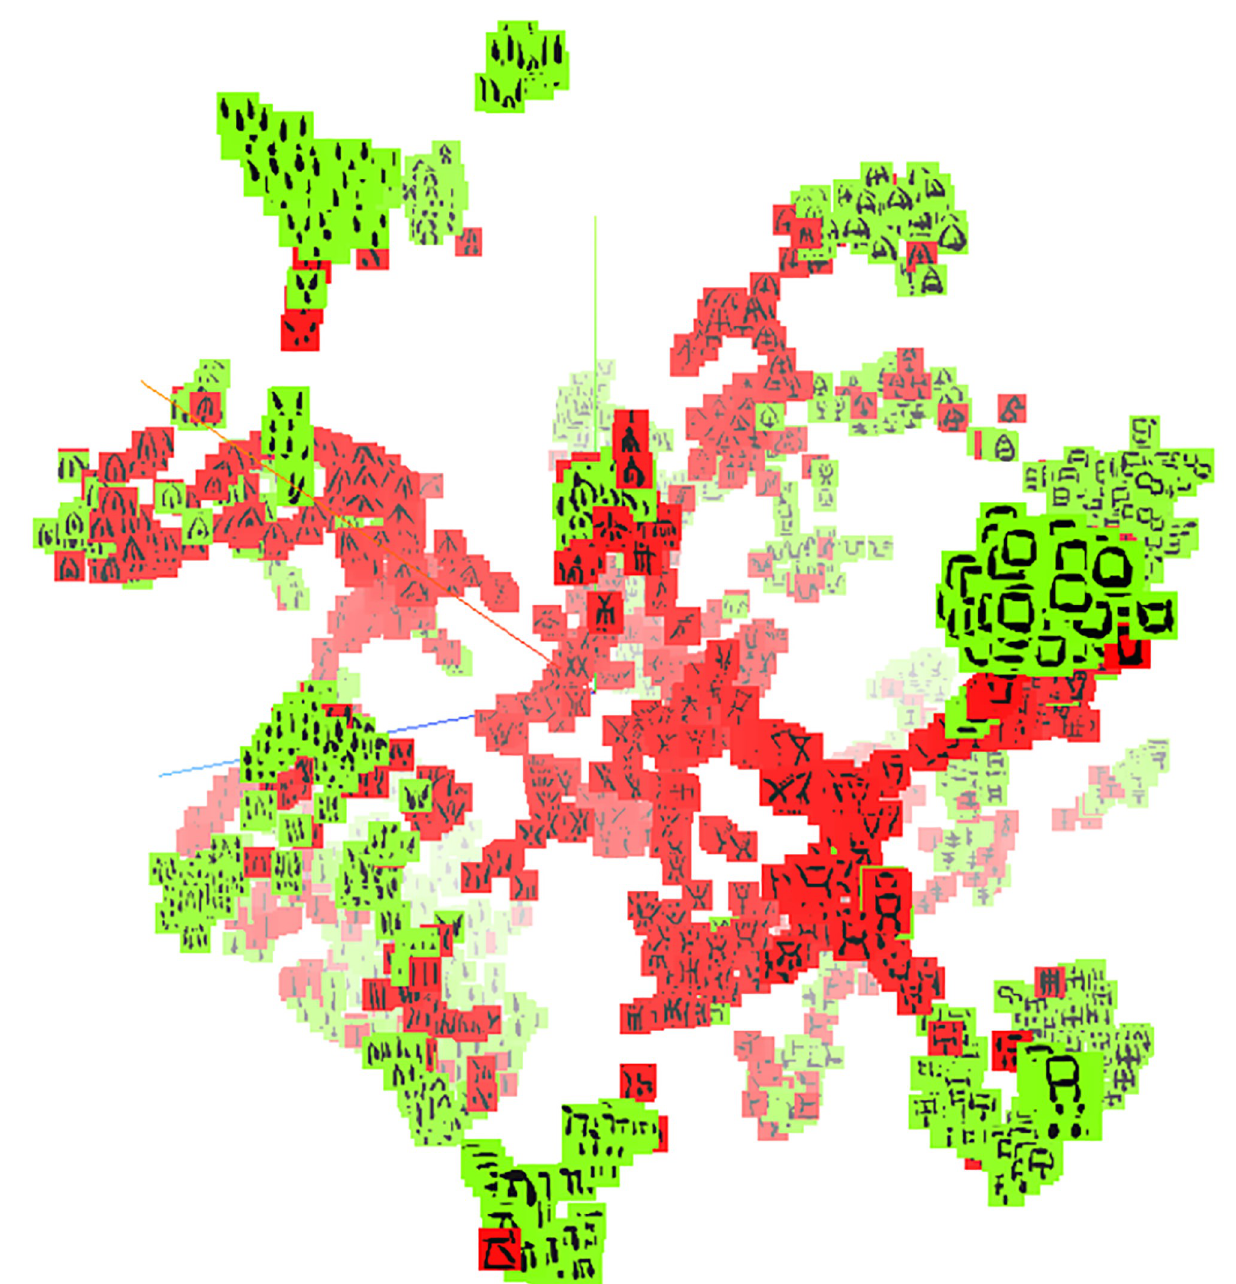
Fig 6. Separation of CM signs from clay tablets (in green) and signs found in other types of inscription (in red) in the 3D scatter plot.